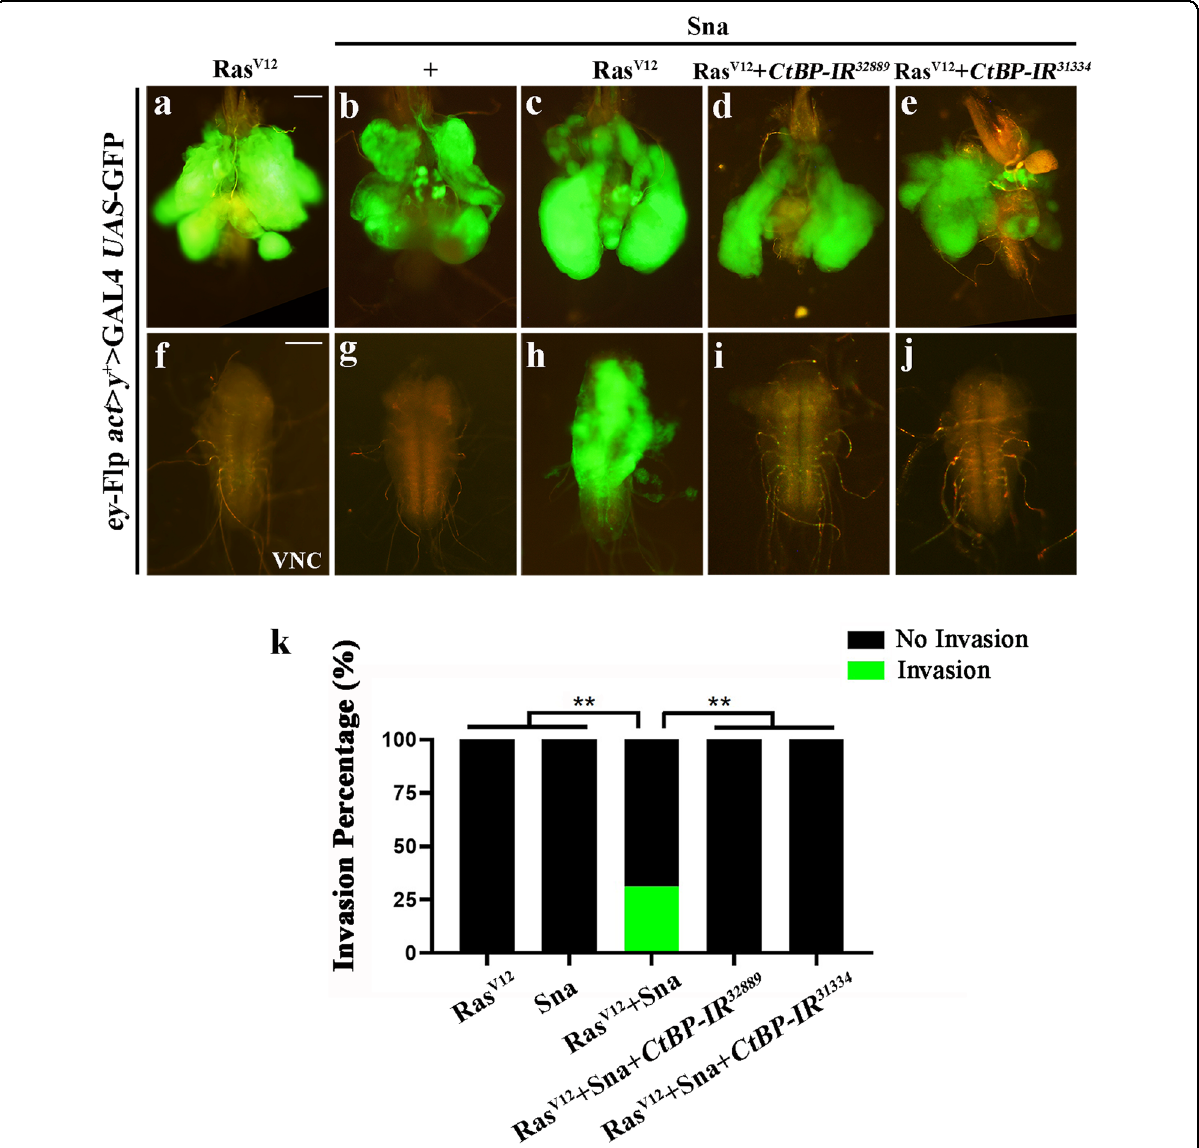
Fig. 4 CtBP is essential for Ras V12 /Sna-triggered tumor invasion. Fluorescent images of larval CCs ( a – e ) and VNCs ( f – j ). Ras V12 clones showed an obvious growth advantage ( a , f ), while overexpression of Sna alone did not promote any tumor-like phenotype ( b , g ). Coexpression of Sna and Ras V12 triggered moderate tumor overgrowth and VNC invasion ( c , h ), which was totally inhibited by knockdown of CtBP ( d , e , i and j ). k Column bar graph of the invasion percentage as shown in fi gures a – e ( a , 0.00%, n = 55; b , 0.00%, n = 36; c , 31.11%, n = 45; d , 0.00%, n = 43; e , 0.00%, n = 27). Chi- squared test was applied to compute P -values, ** P < 0.01. See the electronic supplementary material for detailed genotypes. Scale bar: 100 µm ( a – j